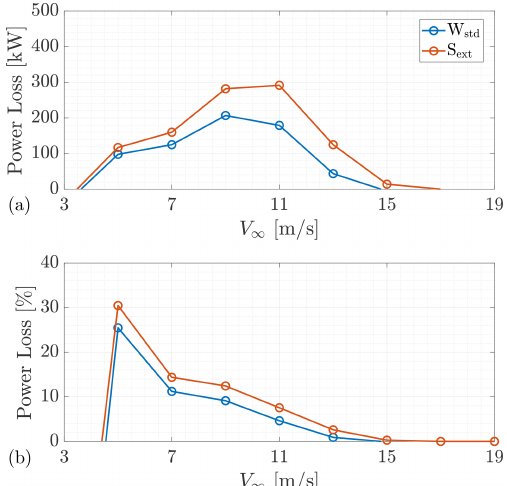
Figure 27. Power losses with a turbulent inflow. (a) Absolute dif- ference. (b) Normalised difference.